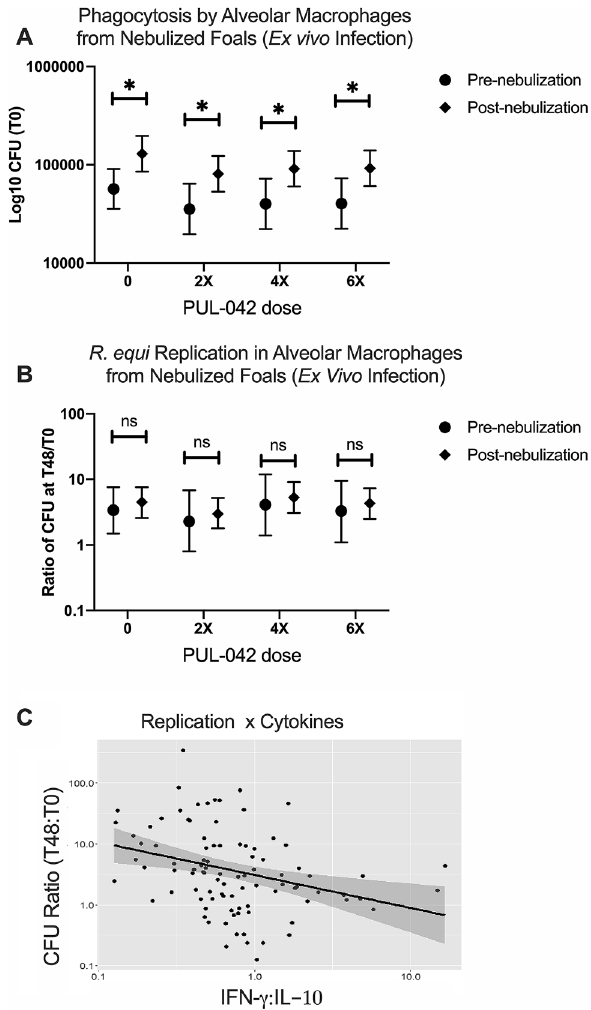
Figure 5. Internalization and intracellular killing of Rhodococcus equi by alveolar macrophages (AMs) collected via bronchoalveolar (BAL) lavage pre (day 2 after birth) and post (day 22, 1 day after the last nebulization). All 48 foals were nebulized with either glycerol 2.8% (PUL-042 0; n = 12), or varying doses of PUL-042 (2×, n = 12; 4×, n = 12; or 6×, n = 12). No foals were infected in vivo with R. equi . Alveolar macrophages were infected with 10 6 virulent R. equi using a multiplicity of infection of 10 bacteria per macrophage (infected) or kept with media only (uninfected control). Cells were then washed and either lysed and diluted immediately (T0) for bacterial determination, or cultured for 48 h on 5% CO2 and then lysed and diluted for CFU counts (T48). There were not significant effects of treatment or age in either phagocytosis (( A ); T0) or replication (( B ); ratio of T48:T0). ( C ) CFU ratio (T48:T0) vs IFNg:IL-10. The CFU ratio (lower ratio = greater intracellular killing) was significantly (P = 0.0075) and negatively associated with the ratio of IFN-g:IL-10 expression ratios (infected/ uninfected). The log10 CFU ratio decreased by 10 (−0.47397) (95% CI, 10 (−0.8149639) to 10 (−0.132983) ). R-value −